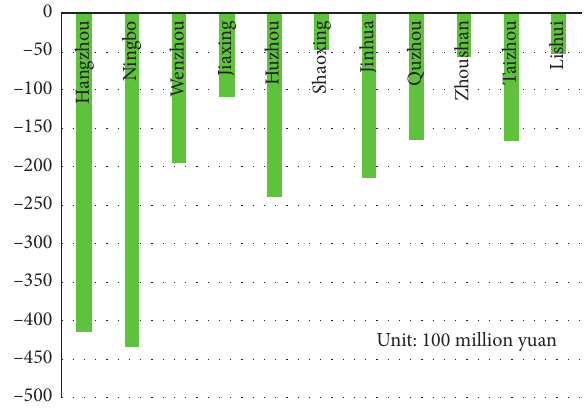
Figure 3: Comparison of structural shift component of secondary industry.